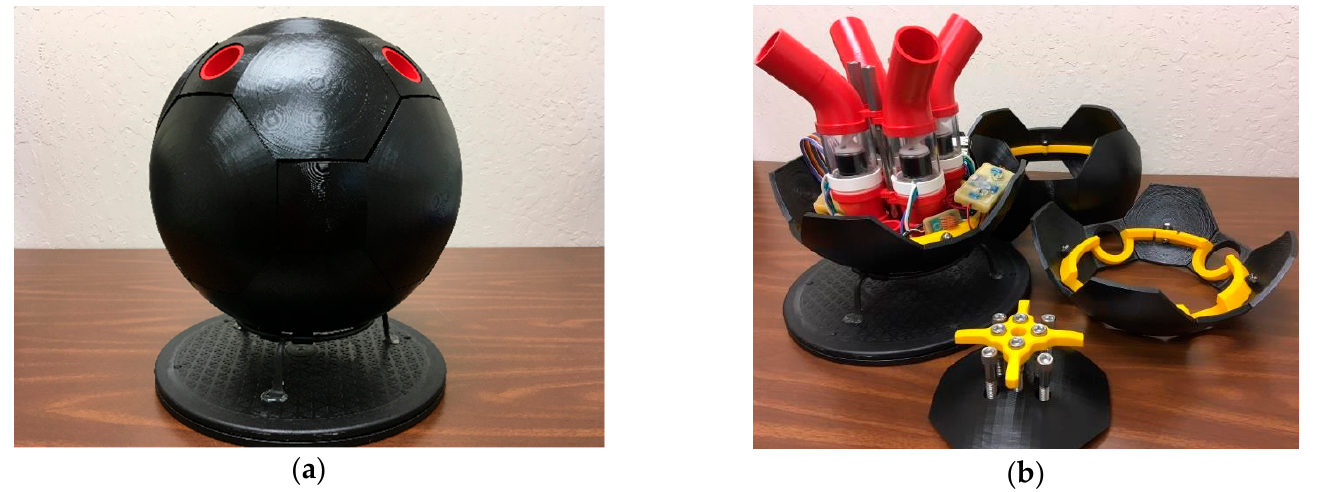
Figure 1. The Wreck Interior Exploration Vehicle (WIEVLE). ( a ) WIEVLE, on its test stand; ( b ) Plated hull removed to reveal WIEVLE’s propulsion system.